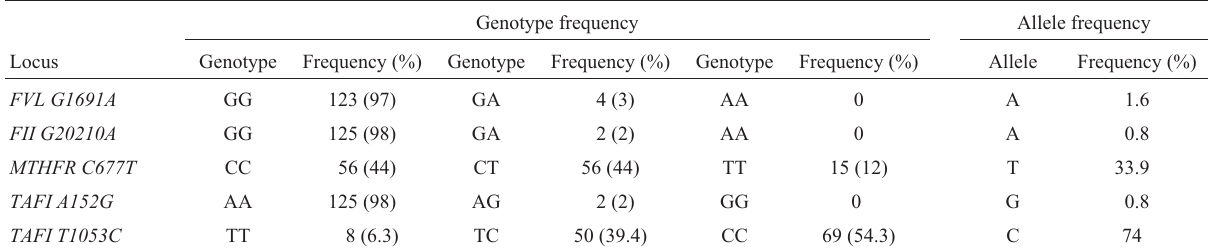
Table 1 - Allele and genotype frequencies of the factor V Leiden ( FVL G1691A ), factor II prothrombin ( FII G20210A ), methylenetetrahydrofolate reductase ( MTHFR C677T ) and thrombin-activatable fibrinolysis inhibitor ( TAFI A152G and TAFI T1053C ) polymorphisms in a population sample (N = 127) from the Brazilian city of